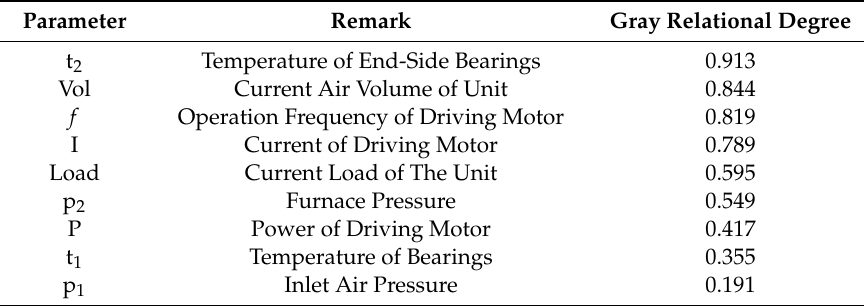
Table 2. Results of grey relational analysis for horizontal vibration.